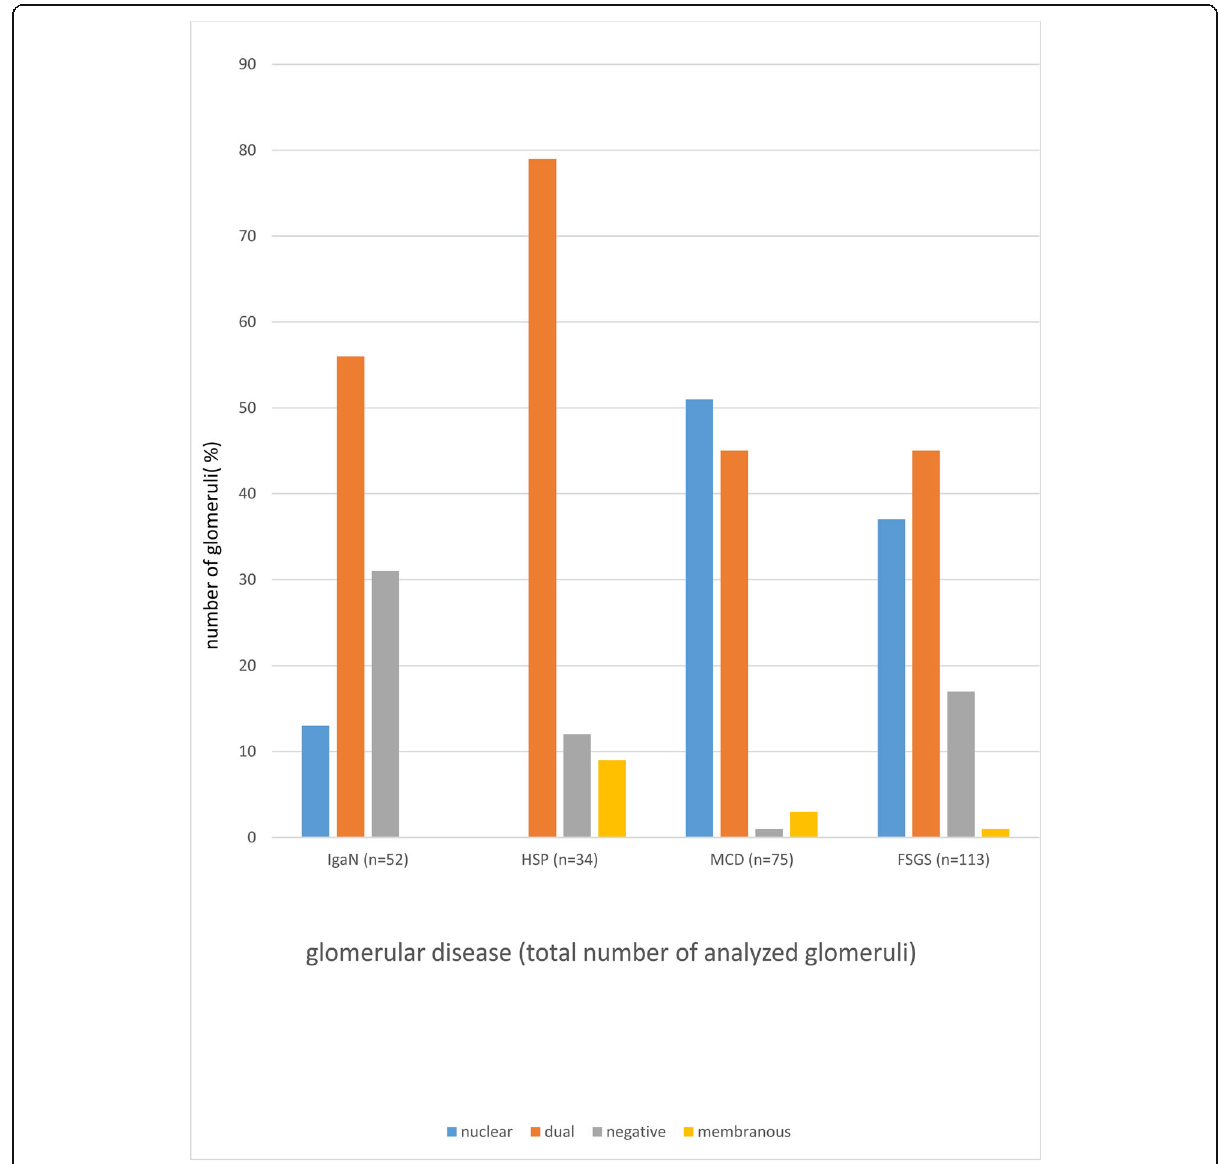
Fig. 3 Distribution of dendrin expression pattern in total number of glomeruli in analyzed types of glomerular